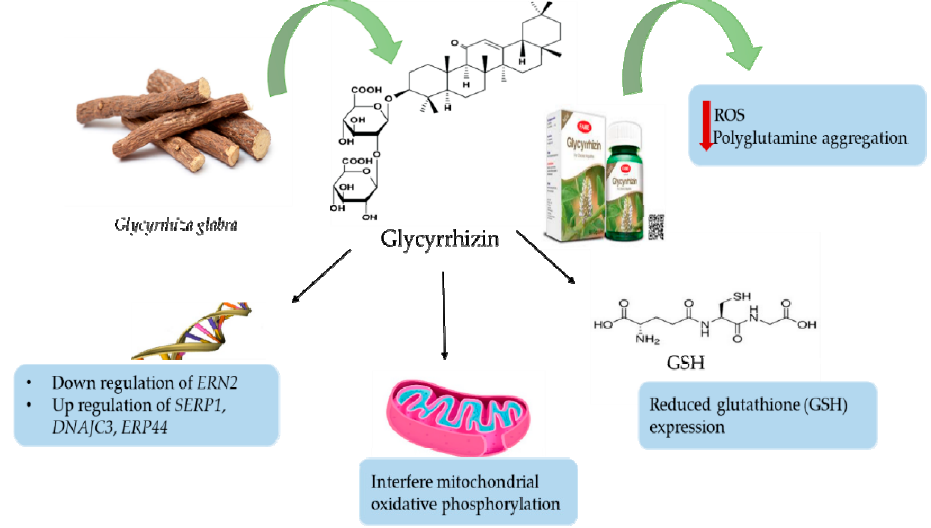
Figure 1. The effectiveness of licorice root extract and its related compound, glycyrrhizin in treating dementia and dementia associated with Alzheimer’s disease (AD). Photo source: https://famepharma.com/glycyrrhizin/